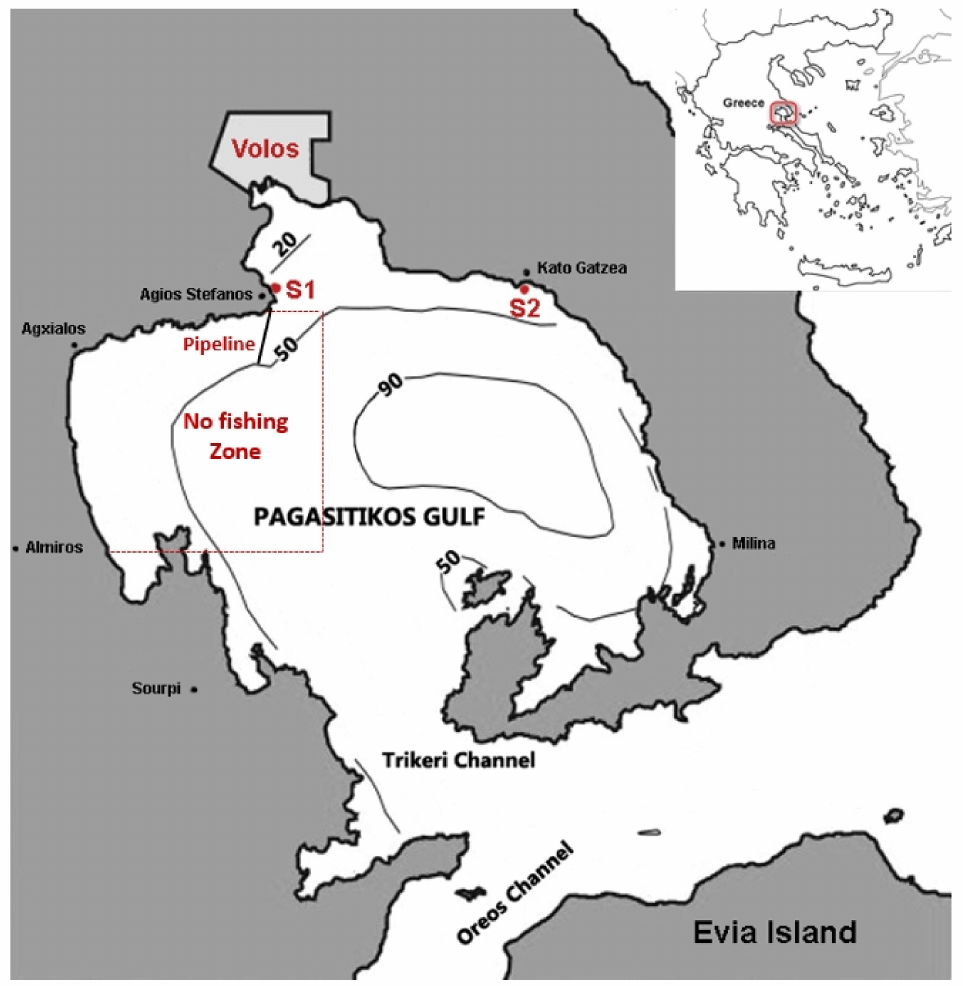
Figure 1. Pagasitikos Gulf depth profile and sampling locations, Site 1 (Agios Stefanos, latitude: 39.306201 and longitude: 22.940283) and Site 2 (Kato Gatzea, latitude: 39.307062 and longitude: